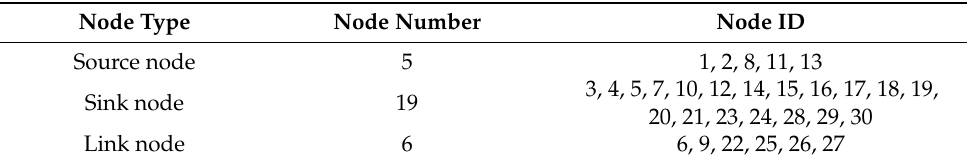
Table 1. IEEE-30 system node type.